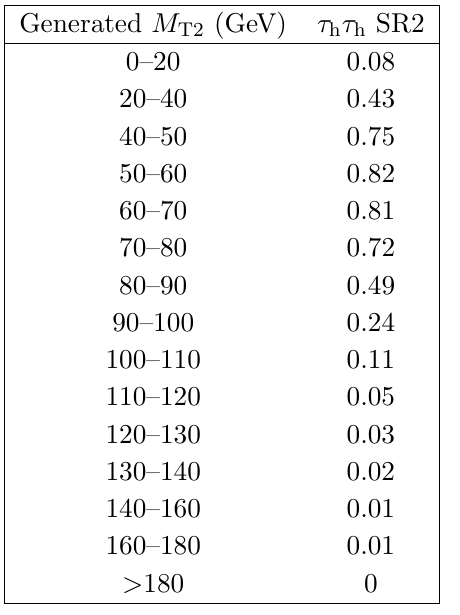
Table 13 . E(cid:14)ciencies of the M T2 requirement in (cid:28) h (cid:28) h SR2 versus generated M T2 . Zero for the e(cid:14)ciency shows the region that the generated M T2 is much greater than the selection cut.